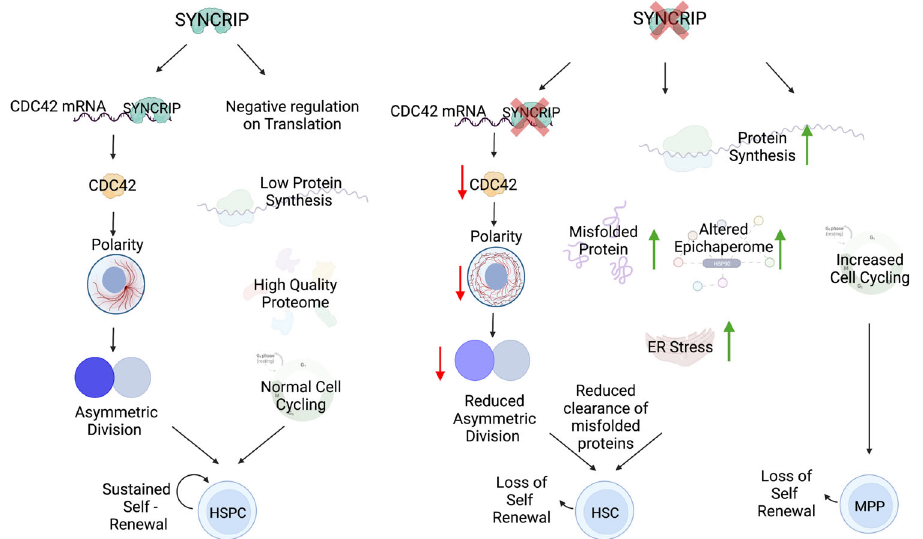
Fig. 7 | Graphical abstract illustrating SYNCRIP controls proteome quality and CDC42-mediated cell polarity and division to maintain self-renewal of reserve HSCs. Model showing mechanism for how SYNCRIP regulates HSPC properties.